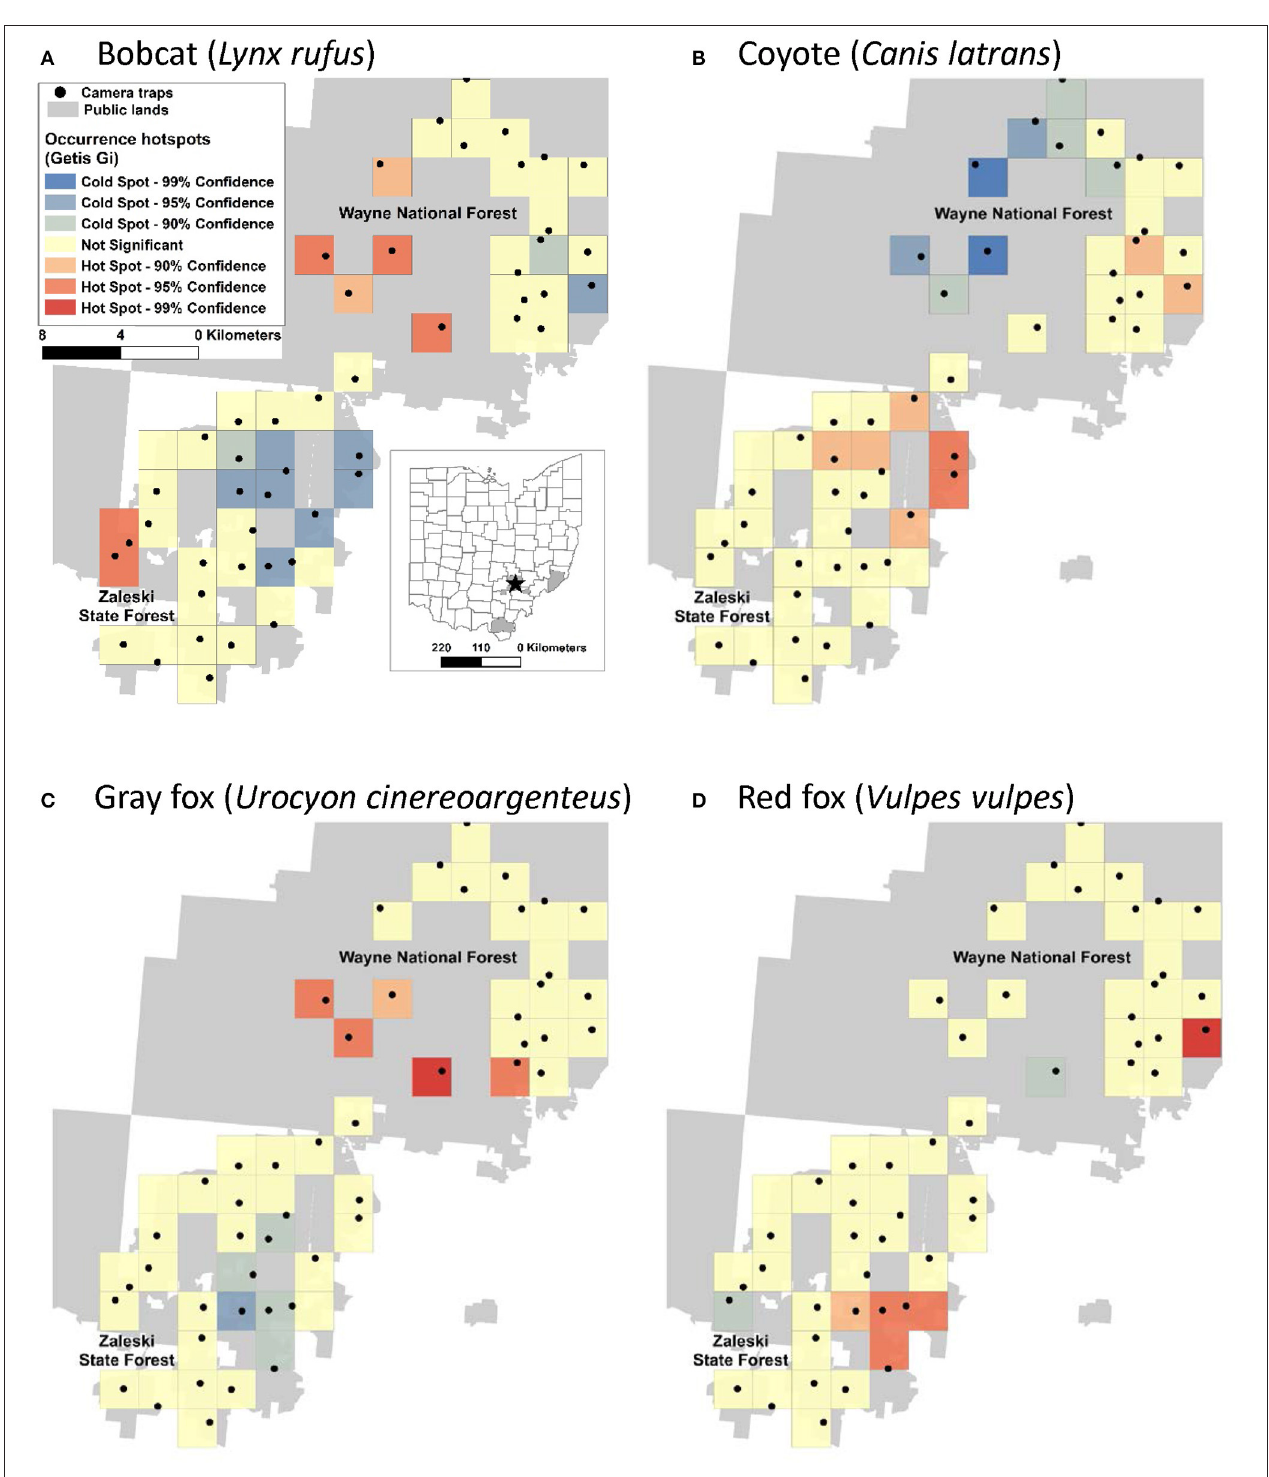
FIGURE 1 | Hotspots of occurrence of two native predators, bobcat (A) and gray fox (C) , and two non-native predators, coyote (B), and red fox (D) in the Wayne National Forest (Athens Unit) and Zaleski State Forest in SE Ohio. The black dots denote camera trap locations within the 2 × 2km grid cells.